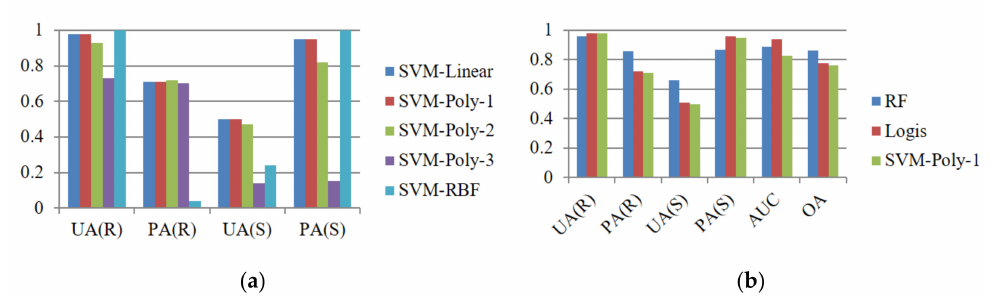
Figure 10. Performances ( Y -axis) of the No. 3 model, where OA, AUC, PA, UA, S, and R represent the overall accuracy, area under the ROC curve, producer’s accuracy, user’s accuracy, landslide source, and runout, respectively. ( a ) Using SVM with linear, the first- to third-order polynomial, and radial basis (RBF) functions; ( b ) comparing the optimal results of Table 4 and ( a ) by using logistic (Logis) regression.